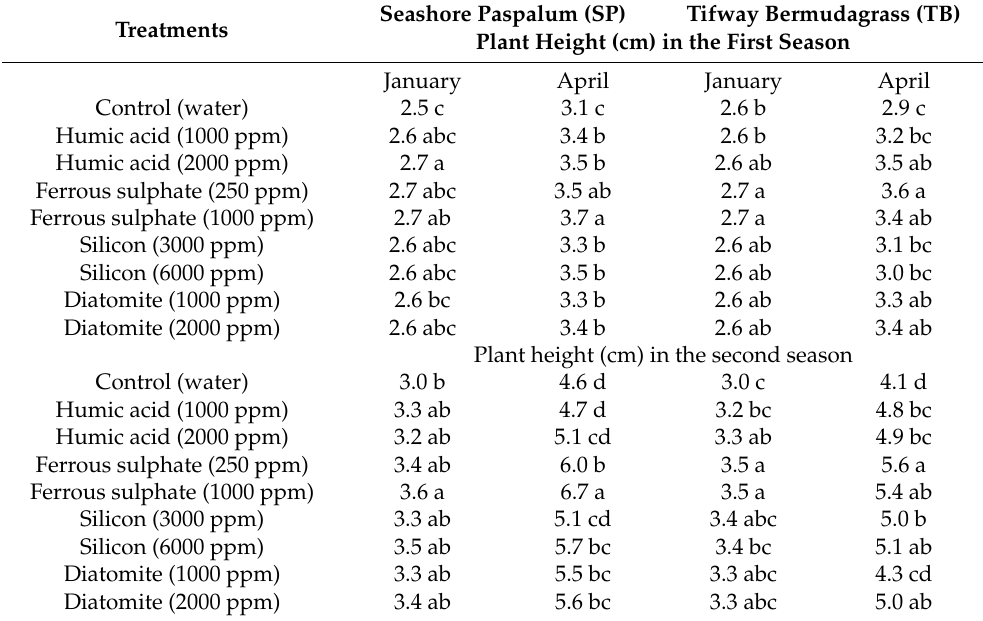
Table 2. Measured mean values of plant height (cm) of seashore paspalum and Tifway bermudagrass treated with different amendments during January and April in two different